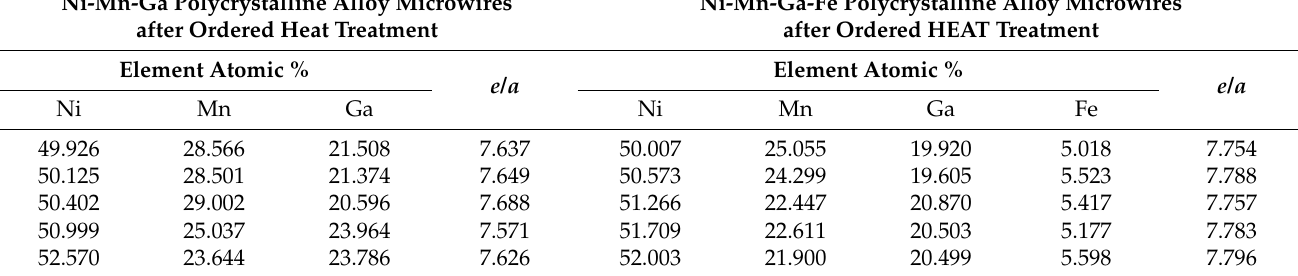
Table 1. Results of the EDS energy spectrum analyzer for the detection of two alloy microwires.